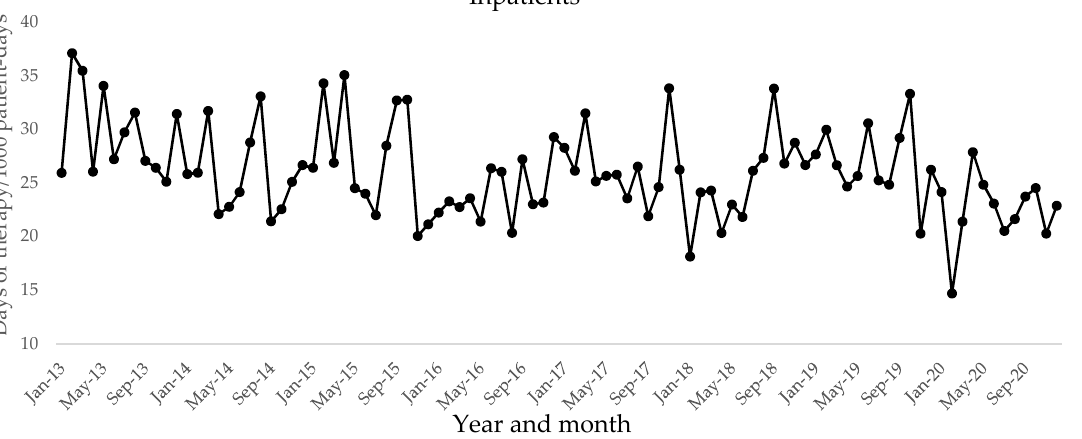
Figure 2. Monthly days of therapy per 1000 patient-days of oral quinolones in inpatients. Table 3. Longitudinal trend of days of therapy from 2013 to 2020. Coef.